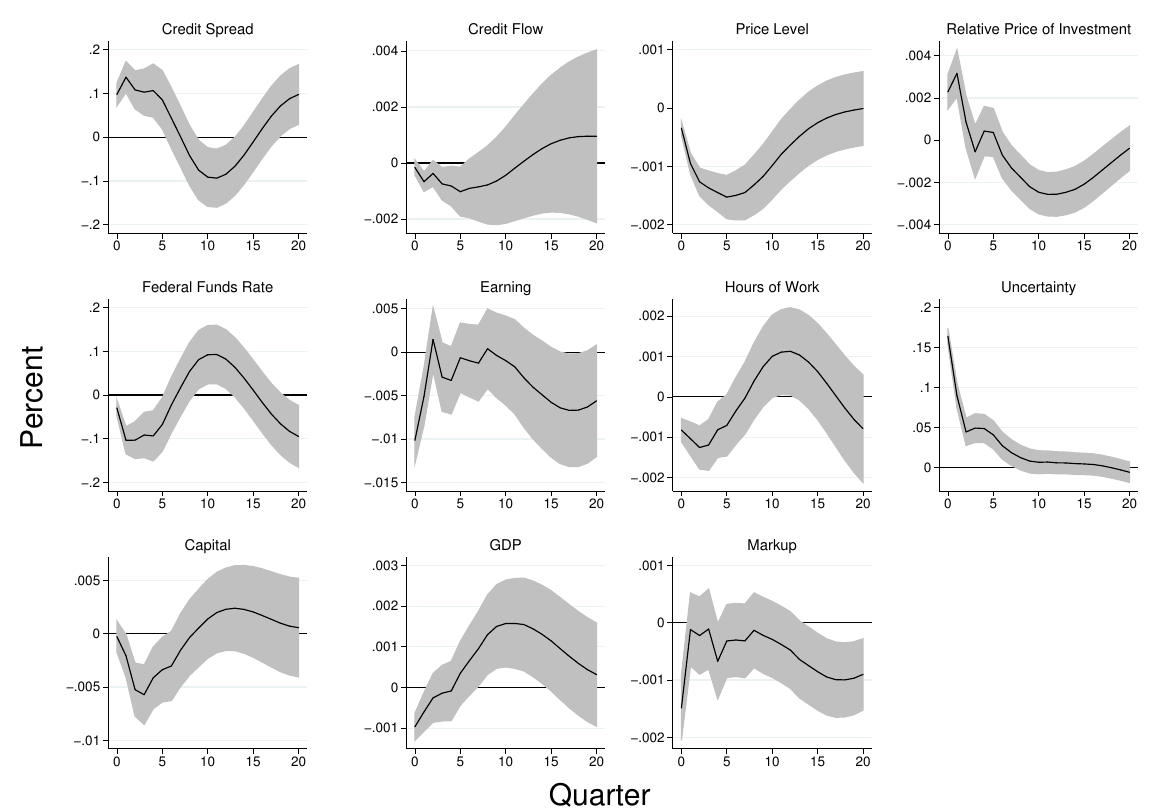
Figure 2. Impulse Responses to Uncertainty Shock in the VAR Model. Notes : Shaded regions represent 95 percent standard error bands. The data are quarterly and span the period 1986Q1-2019Q4. With the exception of the federal funds rate, all the other variables are in log